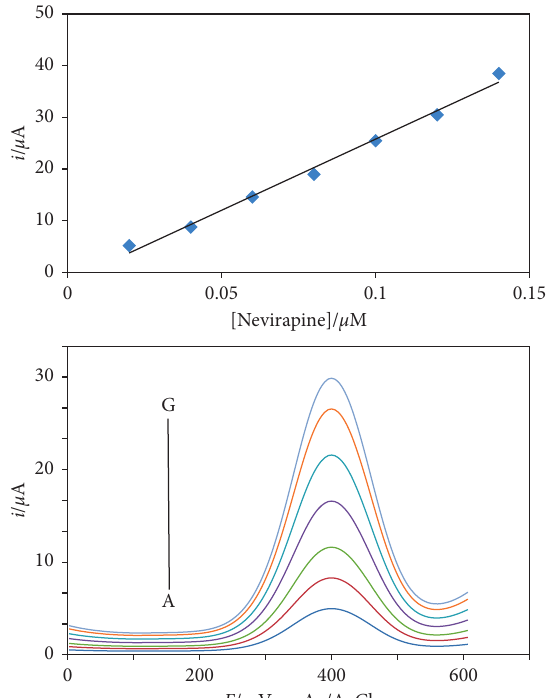
Figure 7: DPVs of TiO 2 /GNR/GCE in different concentrations of nevirapine. Inset plot of i pa ( μ A) versus [nevirapine]/ μ M in 0.1M PBS solution, pH